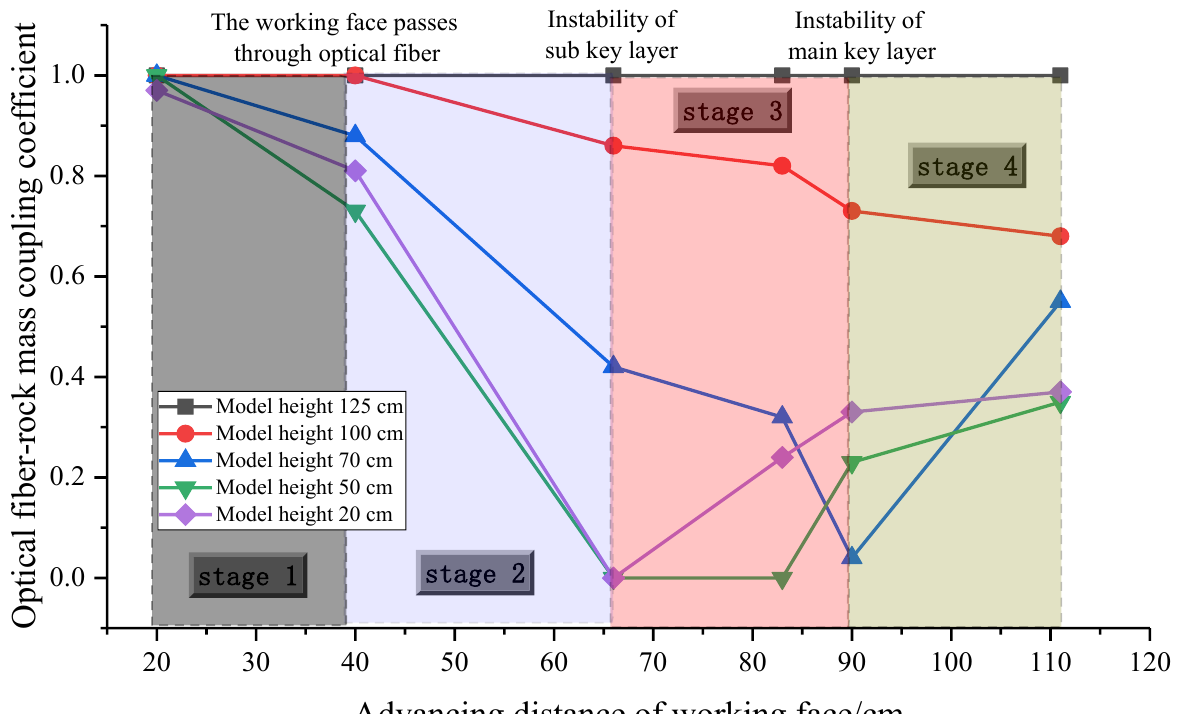
Figure 11. Characteristics stage division for the deformation process of overburden based on the analysis of fiber–rock coupling.